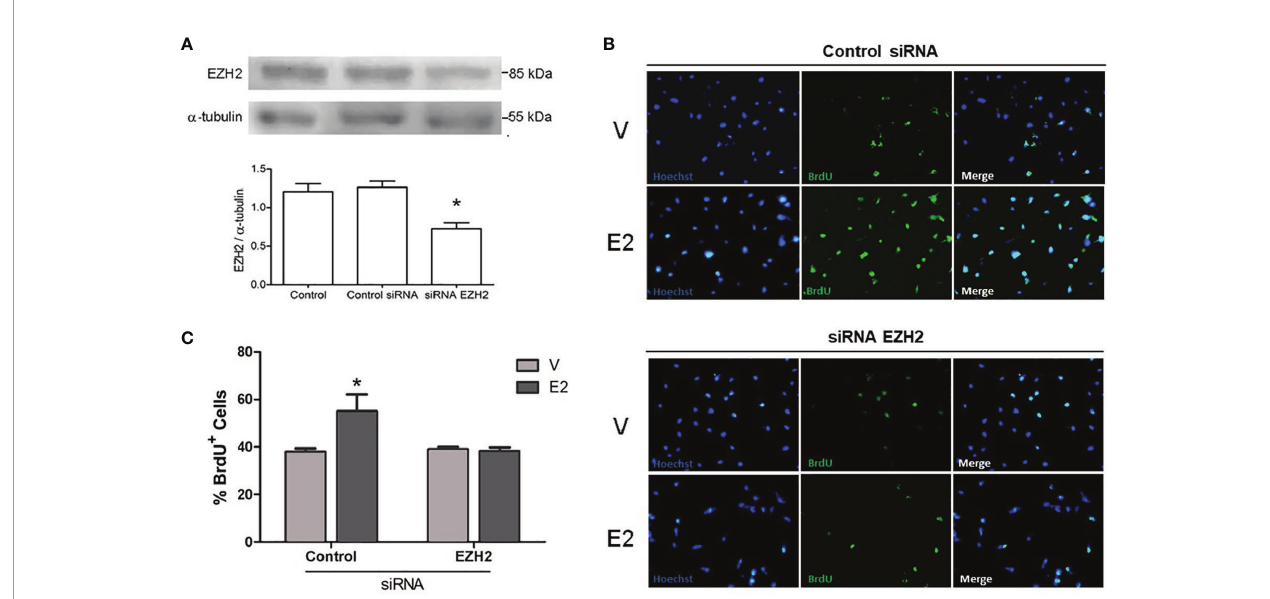
FIGURE 3 | Effect of EZH2 silencing on E2-induced proliferation. (A) Validation of EZH2 silencing. Representative Western blots of EZH2 content in U251 cells transfected with EZH2 siRNA or control siRNA interference (aleatory RNA sequence). Control: cells treated only with transfection reagent. Densitometric data are shown as mean ± S.E.M. *p <0.05. vs. the other groups. Analysis of proliferative capacity of U251 cells transfected with control siRNA or EZH2 siRNA and treated with E2 (10 nM) or V (0.02% CDX) for 48 h. (B) Representative images of BrdU incorporation in proliferating U251 cells, (C) and its corresponding quanti fi cation graphs showing the percentage of BrdU positive cells. Bars represent the mean ± S.E.M. n =3. *p < 0.05. vs. the other